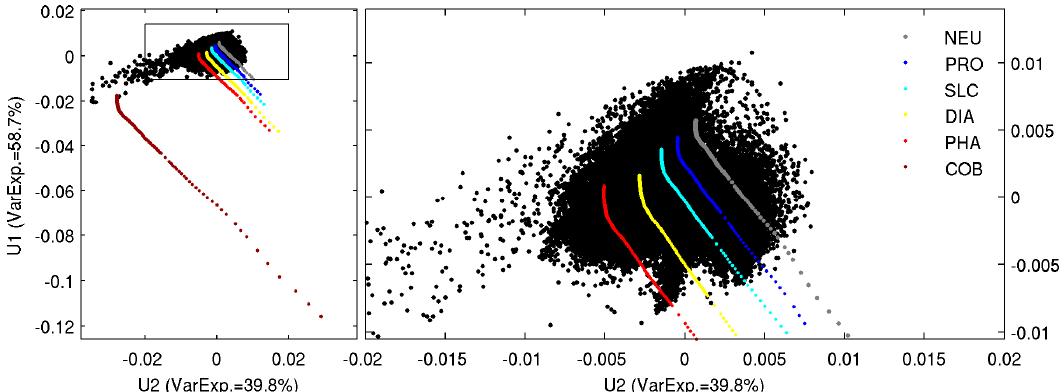
Figure 7. The dimensionless U 1 –U 2 plane derived from the singular value decomposition (SVD) of NNs matrix. The colored symbols represent the location of the typical values (synthetic matrix Rs ) of the PFTs at different Chl-a concentrations; the black dots correspond to values derived from the observations at each pixel in the R matrix. Abbreviations are the same as in Figure 5.